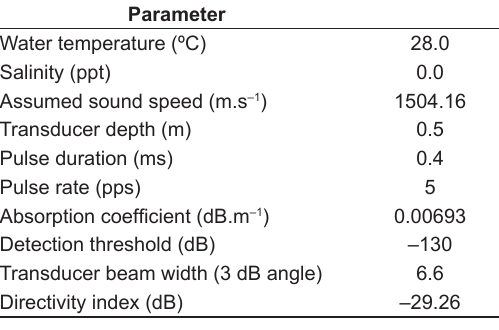
Table 1. Parameters of initial settings of echo sounder (Biosonics DT-X - split-beam, 200 kHz) to collect field data.